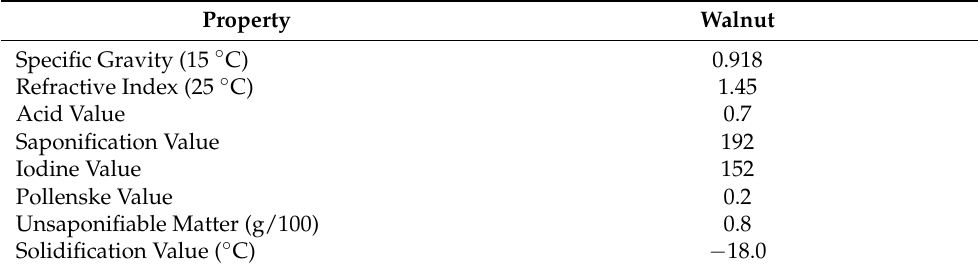
Table 1. The chemical composition of walnut oil (adapted from Dufoo-Hurtado et al. [19].